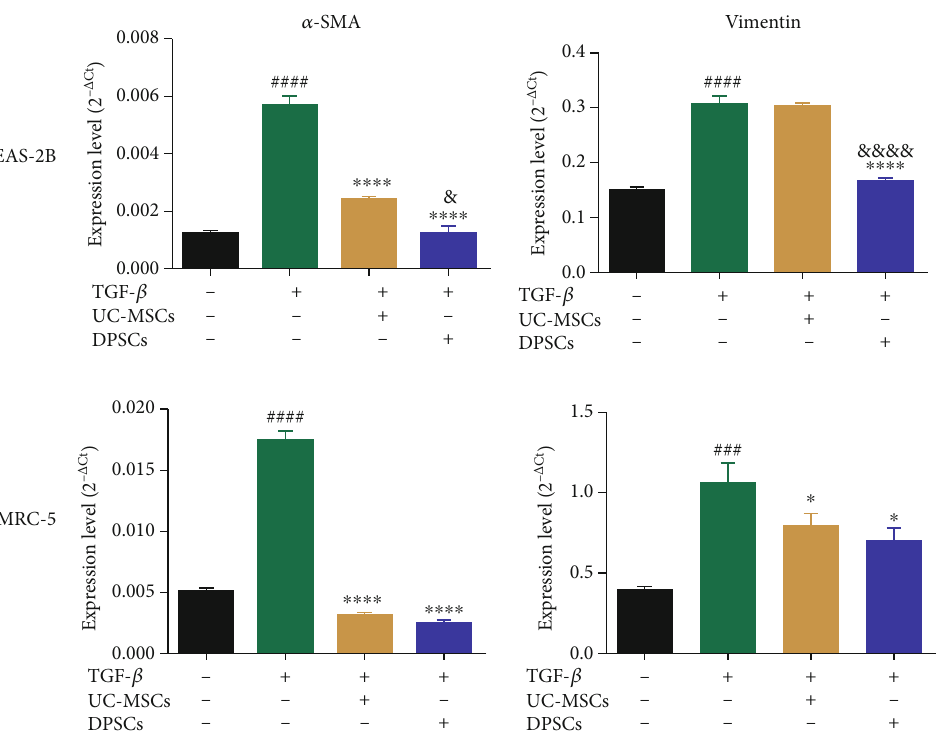
Figure 3: DPSCs alleviate the fi brotic response in BEAS-2B and MRC-5 cells better than UC-MSCs. The expression of the fi brosis-related cytokines α -SMA and vimentin in BEAS-2B and MRC-5 cells stimulated with TGF- β was evaluated by qPCR. Each experiment was performed in triplicate; the data are shown as the means ± SEM . ANOVA followed by Tukey ’ s multiple comparisons test was used to evaluate these data. ### P < 0 : 001 and #### P < 0 : 0001 vs. Con; ∗ P < 0 : 05 and ∗∗∗∗ P < 0 : 0001 vs. TGF- β ; & P < 0 : 05 and &&&& P < 0 : 0001 vs. UC-MSCs. Con: control; UC-MSCs: umbilical cord mesenchymal stem cells; DPSCs: dental pulp mesenchymal stem cells; α -SMA: α - smooth muscle